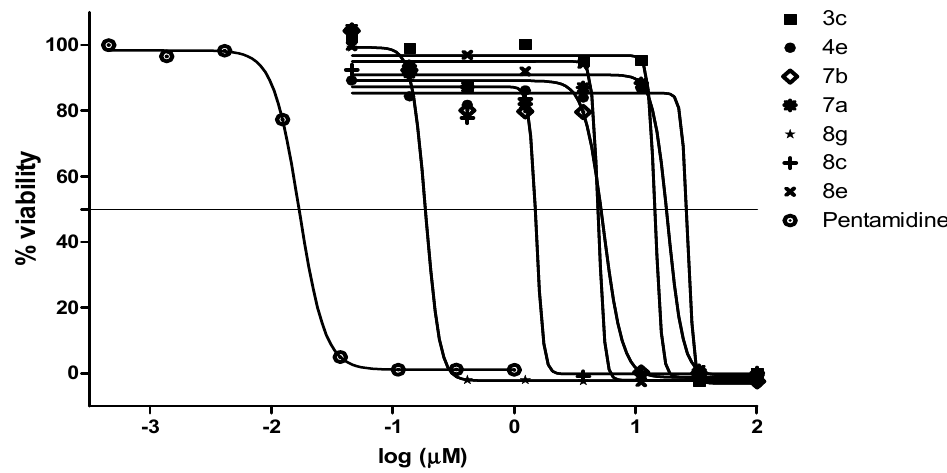
Molecules 2021 , 26 , x FOR PEER REVIEW